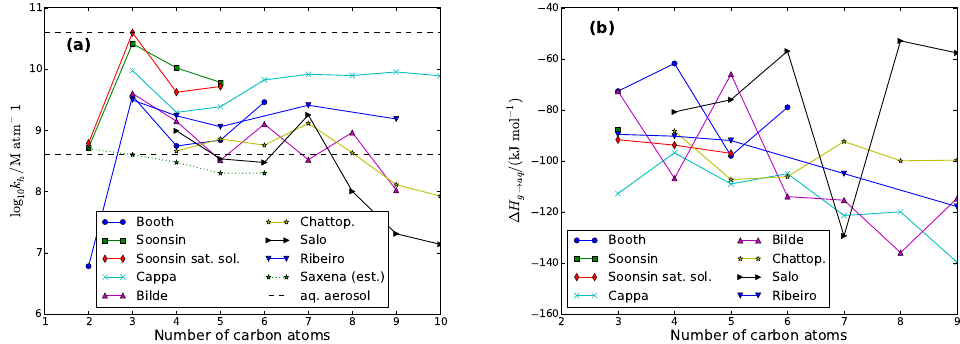
Fig. 5. log 10 k h (a) and 1H g → aq (b) of linear diacids, grouped per data source of solid state vapour pressure. The range where partitioning to aqueous aerosol, based on water content only, is neither complete nor negligible, is also indicated.